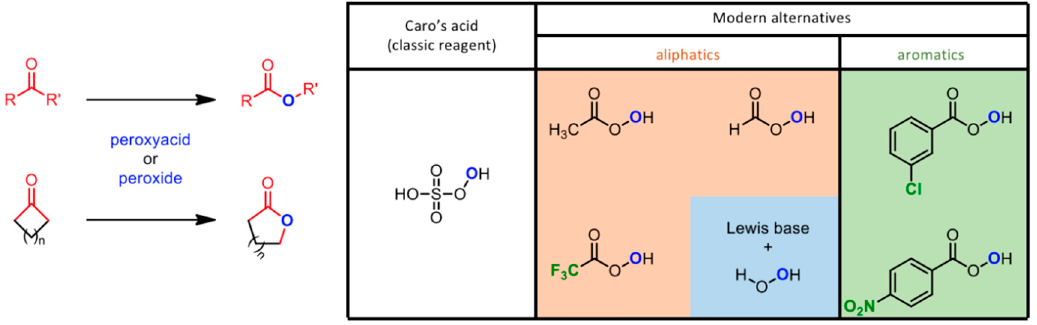
Figure 3. Baeyer ‐ Villiger reaction protocols, and the evolution of commercially available oxidative